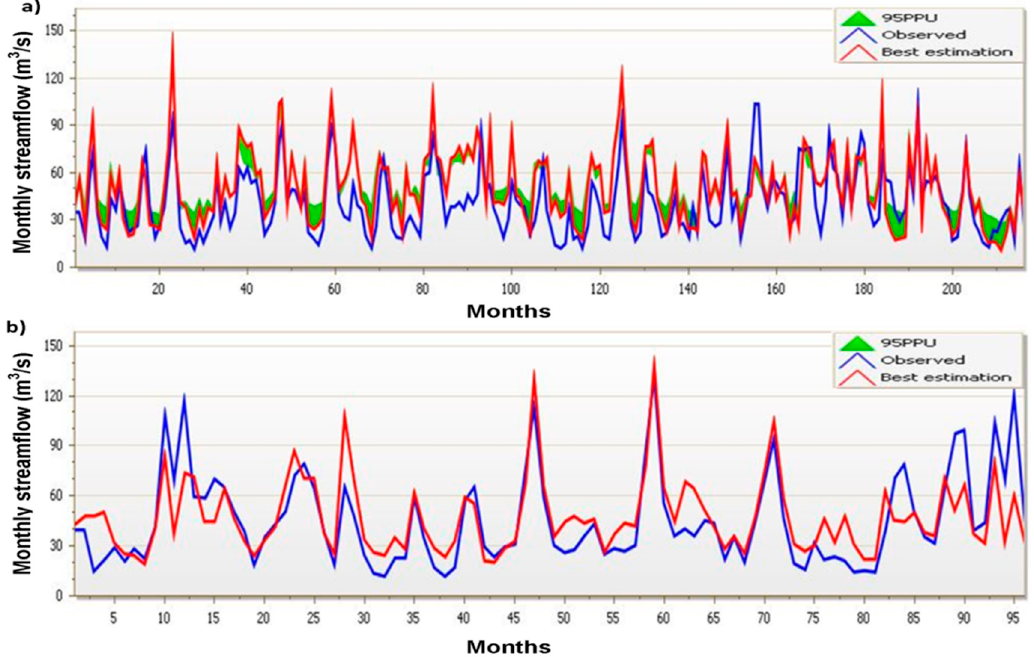
Figure 12. Plot of the observed and simulated streamflow for the calibration (1981–1998) and validation (1999–2006) periods at SKC station.